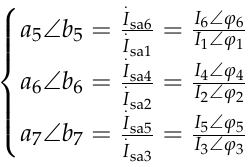
Table 3. Structural parameters of the cable.